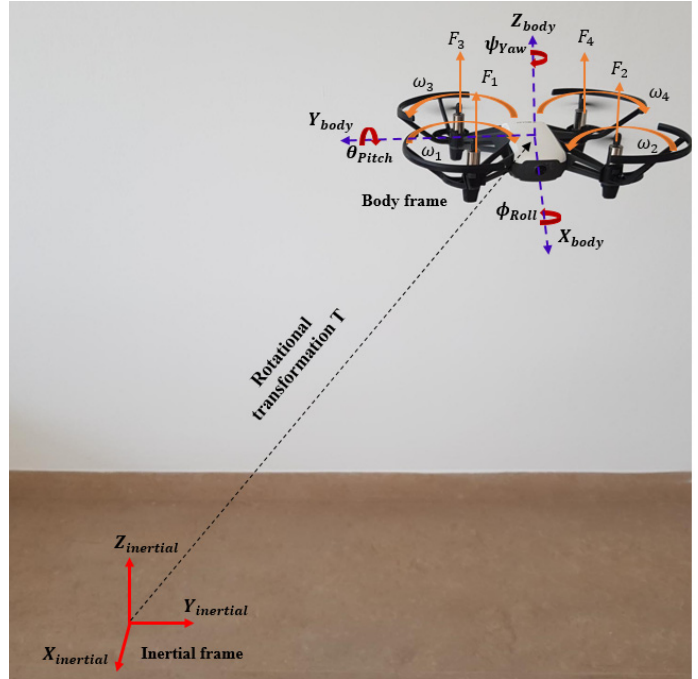
Figure 4. Modeling frame assignments for the Tello quad-rotor [31].